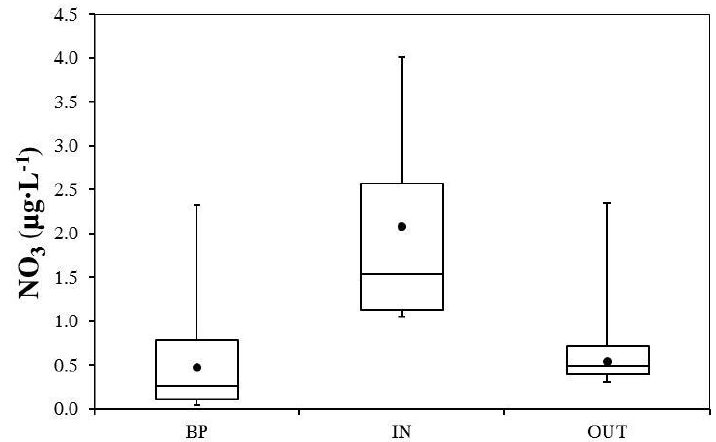
Figure 5. Concentration of nitrate (NO 3 ) in the BP (n = 18 samples), inflow water (IN) (n = 14 samples) and outflow water (OUT) (n = 6 samples). Each box shows the median and range between first and third quartile of all samples, while the whiskers show the minimum and maximum values. The mean (●) is also shown.